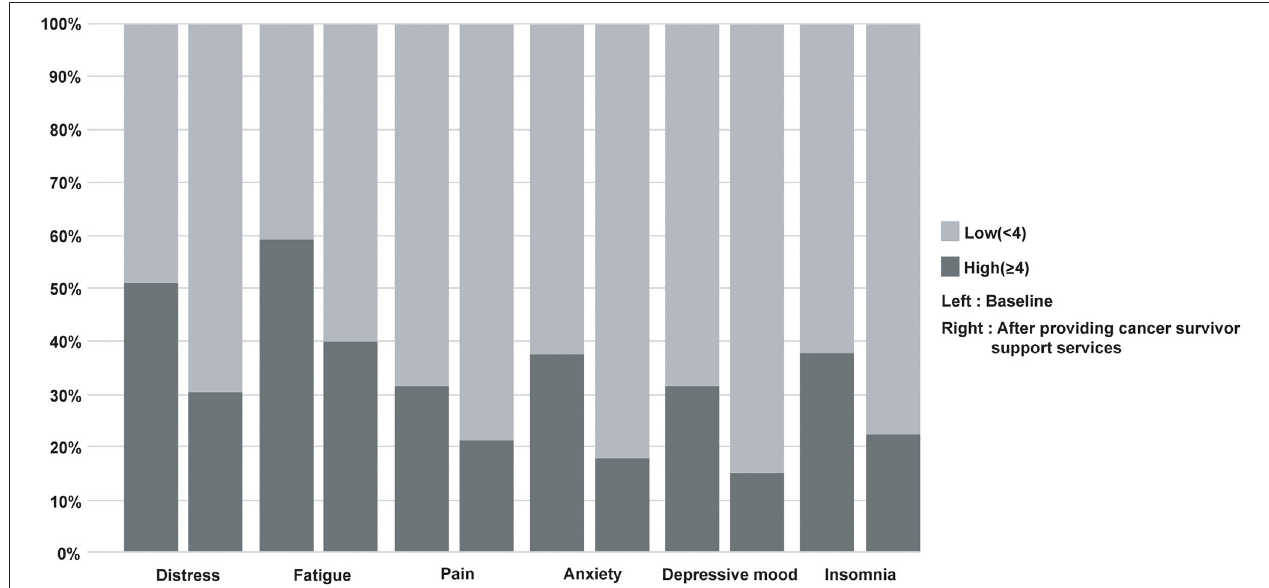
FIGURE 1 | Changes in the proportion of high scores in distress, fatigue, pain, anxiety, depressive mood, and insomnia after providing support services for cancer survivors. A McNemar test was performed. All p < 0.001.